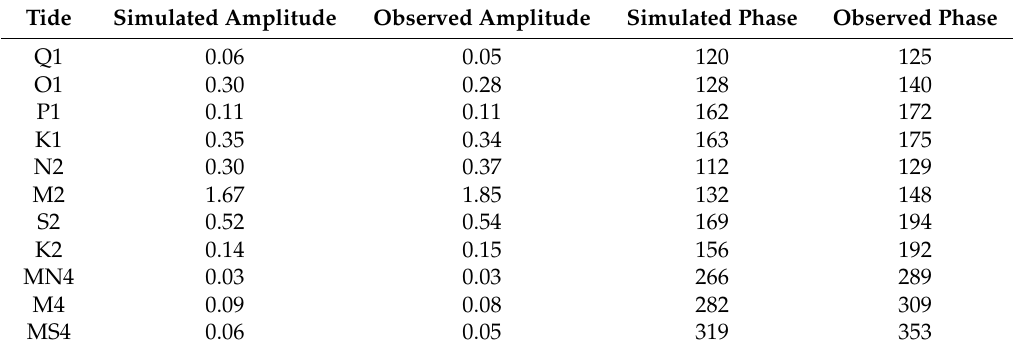
Table 1. Comparison of the amplitude (m) and phase ( ◦ ) between that simulated and observed at XM.